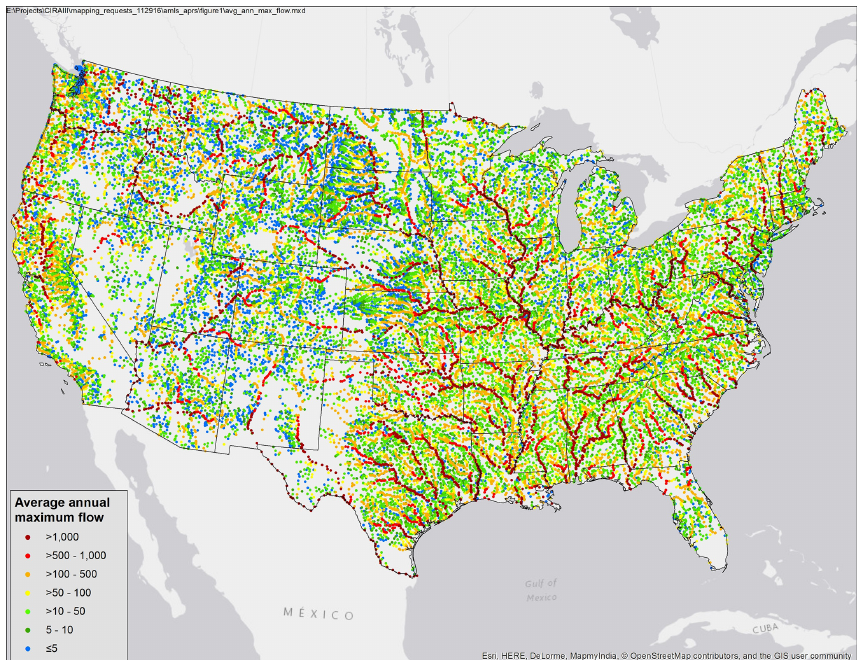
Figure 1. Locations of the 57116 stream segment with hydrologic projections used in our analysis. Color corresponds to the baseline average annual maximum flow for each segment, in m 3 s − 1 .